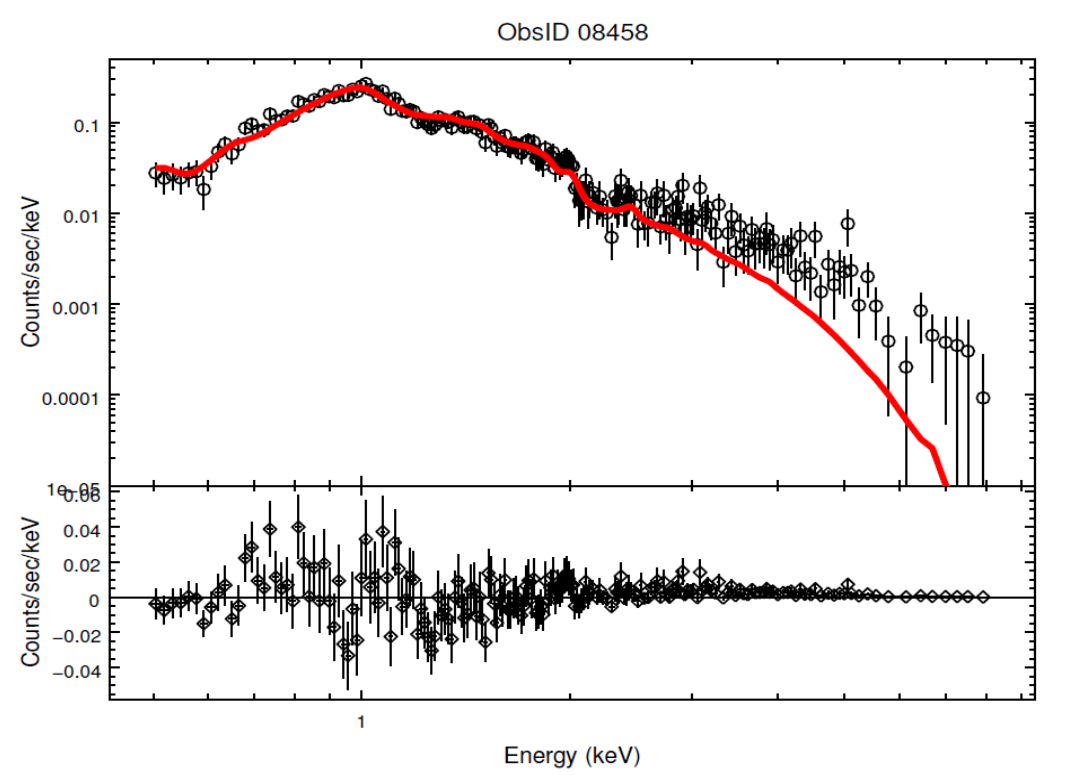
Figure 5. TV Cas Spectrum from Chandra Observation ID 08458.